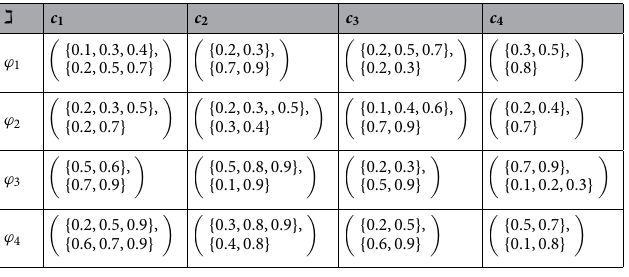
Table 1. FHFR relation in U